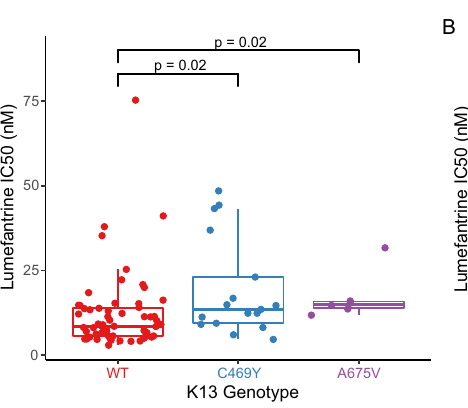
correspond to the median, and minimal and maximal bounds correspond to the 25th and 75th percentiles, respectively. Whiskers extend to extreme values no further than 1.5x the IQR from the 25th or 75th percentiles. WT, wild type. Source data are provided as a Source Data fi